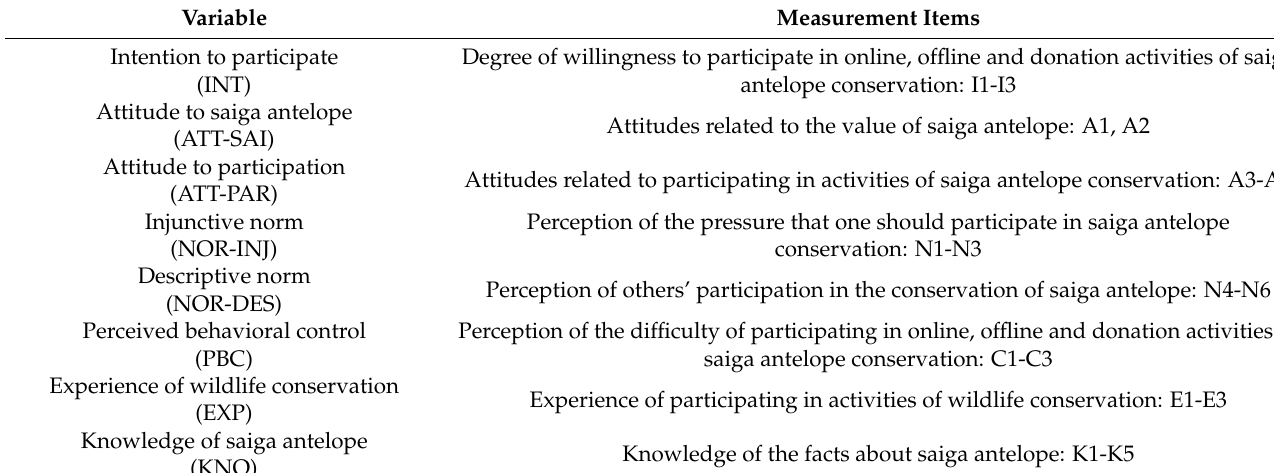
Table 1. Measurement items of each